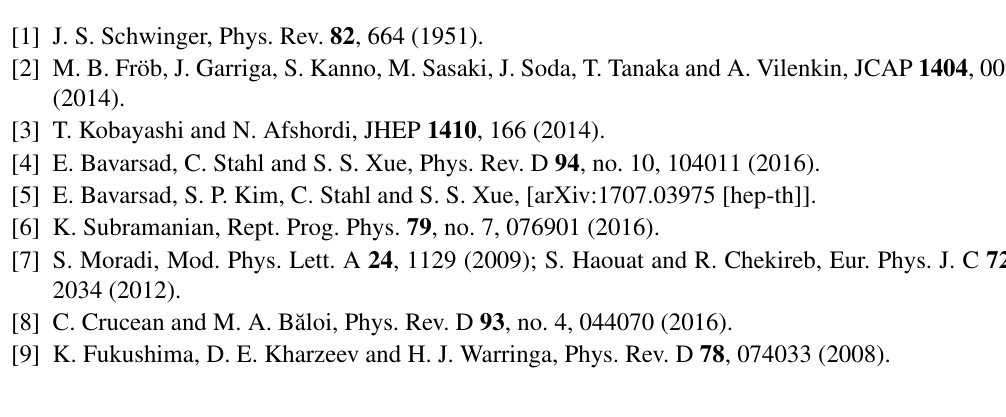
Figure 3: Left (right) panel: in the infrared regime, for di ff erent values of (cid:31) ( λ ), the normalized σ / e 2 H Figure 2: Left (right) panel: for di ff erent values of (cid:31) ( λ ), the normalized conductivity σ/ e 2 H B conductivity σ/ e 2 H is plotted as a function of λ ( (cid:31) ), in the lowest Landau state n = 0 with µ = 1. (cid:31) (cid:30) µ = 10 − 4 where W is the Whittaker function. In the regime of λ 1 the semiclassical condition (6) is satis- (cid:31)